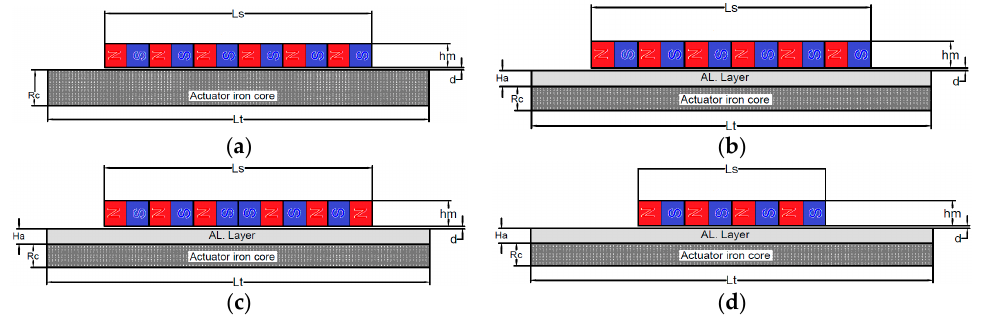
Figure 1. Axisymmetric view for the eddy current damper configurations: ( a ) Model I, ( b ) Model II, ( c ) Model III, ( d ) Model IV.